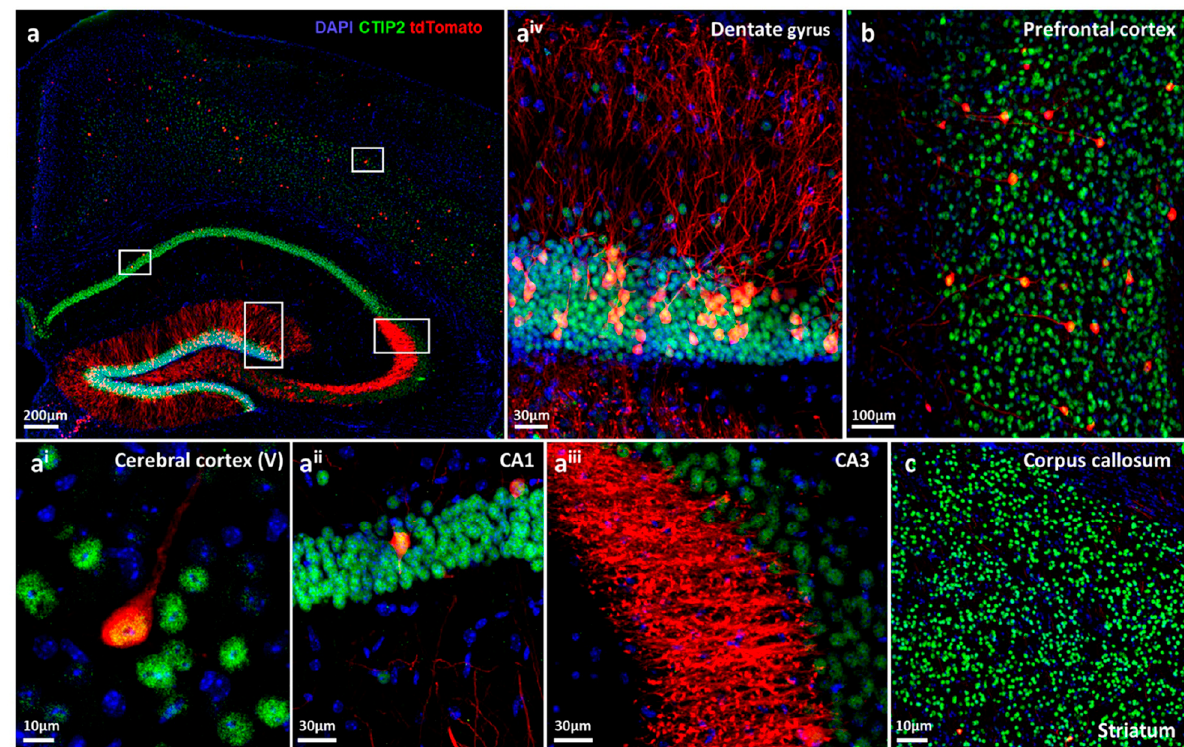
Figure 2. Immunohistochemical characterization of functional hypoxic pyramidal neurons in CaMKII α -CreERT2- ODD::R26R-tdTomato reporter mice. ( a ) Overview image of an eight-week-old female mouse after exposure to complex running wheel (CRW) showing distinct labelling of neurons with tdTomato fluorescent protein (red), co-immunostained with the neuronal marker Ctip2 (green) and DAPI (blue) as nuclear counterstain. White frames denote magnifications given in a i – a iv . ( a i ) Image of cortical layer V showing a neuron with tdTomato+ and Ctip2+ co-localized signal. ( a ii ) Some cornu ammonis (CA1) pyramidal neurons are tdTomato positive. ( a iii ) In CA3, just a few neuronal cell bodies display the tdTomato signal; however, strong staining is observed in stratum lucidum, rendering neuronal morphological details such as dendritic spines and synapses easily distinguishable at high resolution. ( a iv ) Close-up image of the superior plate of the dentate gyrus, demonstrating densely tdTomato-expressing granular neurons and remarkable labelling of neutropil. ( b ) A subset of neurons in prefrontal cortex and their processes are also tdTomato labelled. ( c ) CaMKII α expressing tdTomato+ neurons are sparsely present in the striatum. Scale bars represent 200 µ m ( a ), 10 µ m ( a i , c ), 30 µ m ( a ii , a iii and a iv ), and 100 µ m ( b